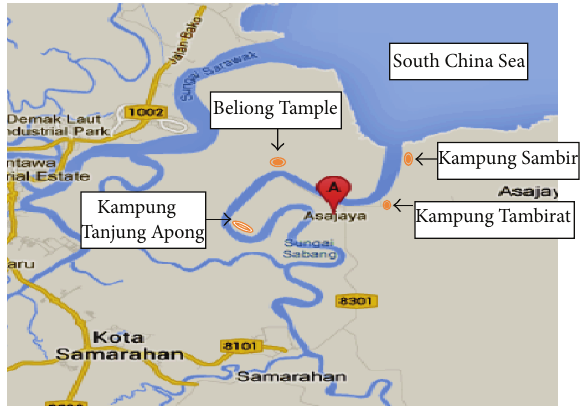
Figure 1: Map of Asajaya showing sampling sites.